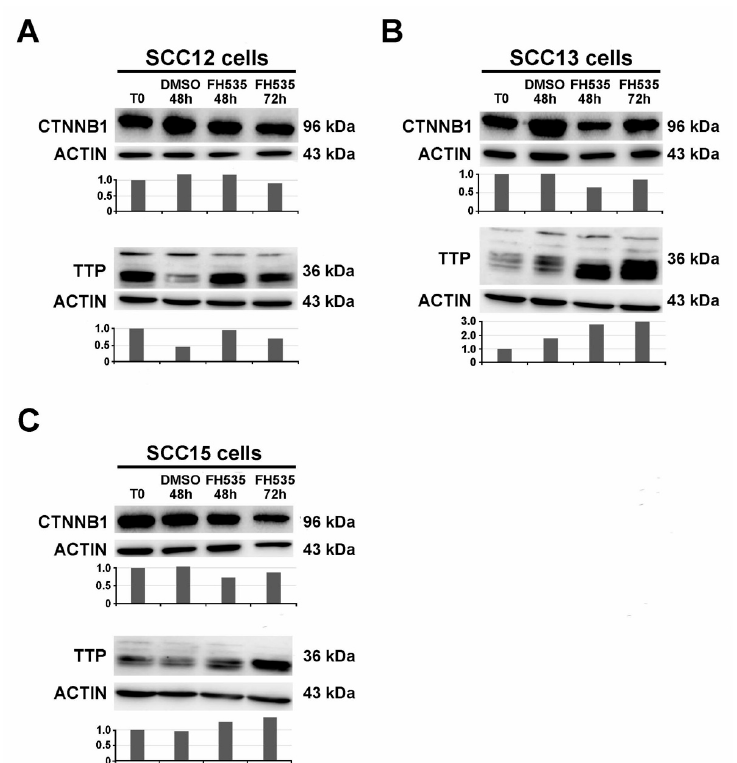
Figure 3. CTNNB1 (96 kDa) and TTP (36 kDa) expression in SCC cell lines treated with FH535, inhibitor of Wnt / CTNNB1 signal pathway. T0 refers to the beginning of the treatment with FH535 or DMSO, respectively. Analysis of the treatment was performed at 48 and 72 h by Western Blot. In the panels ( A – C ) show expression of CTNNB1 and TTP in SCC12, SCC13 and SCC15 respectively. The plot below indicates the normalized densitometric analysis of immunoblot.